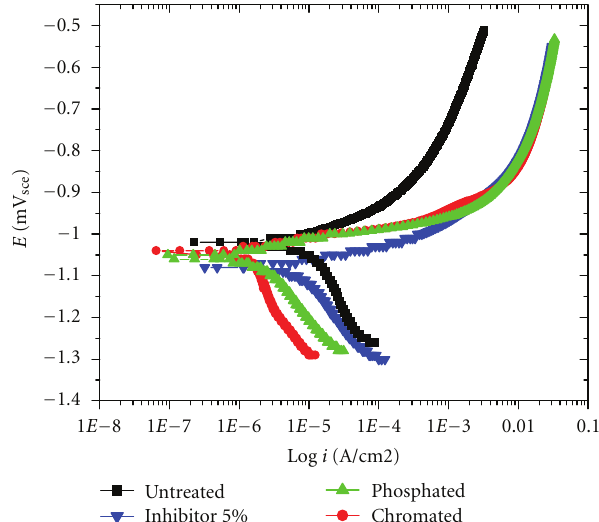
Figure 3: Corrosion performance of galvanized steel with various surface conditions immersed in a 0.5M NaCl solution during 134 days.